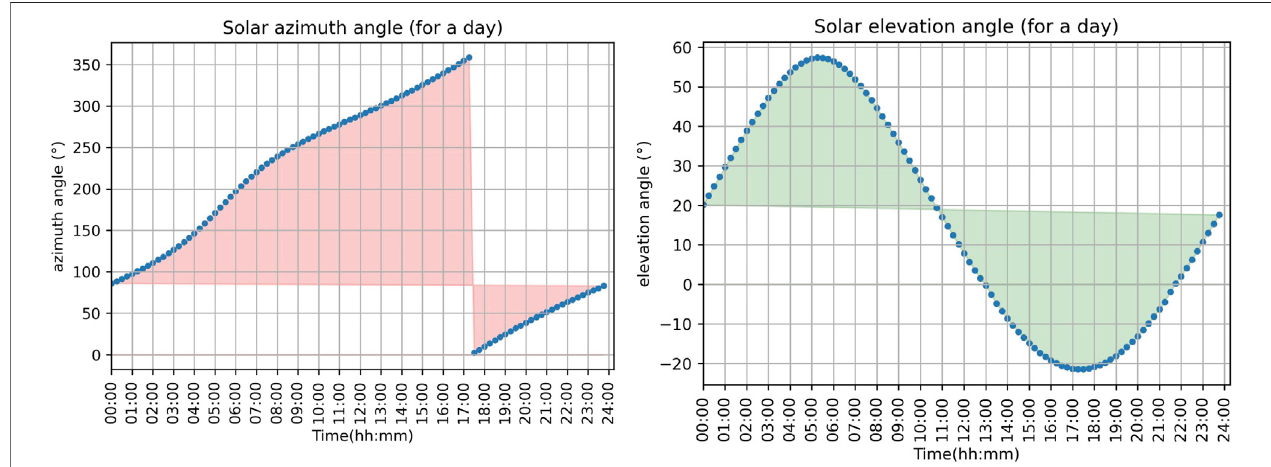
FIGURE 14 | Solar elevation and azimuth change for the Mount Meager area during August 2021. Note the change of solar elevation angle relative to change of solar azimuth angle during the day. Data from (https://keisan.casio.com/exec/system/1224682277).